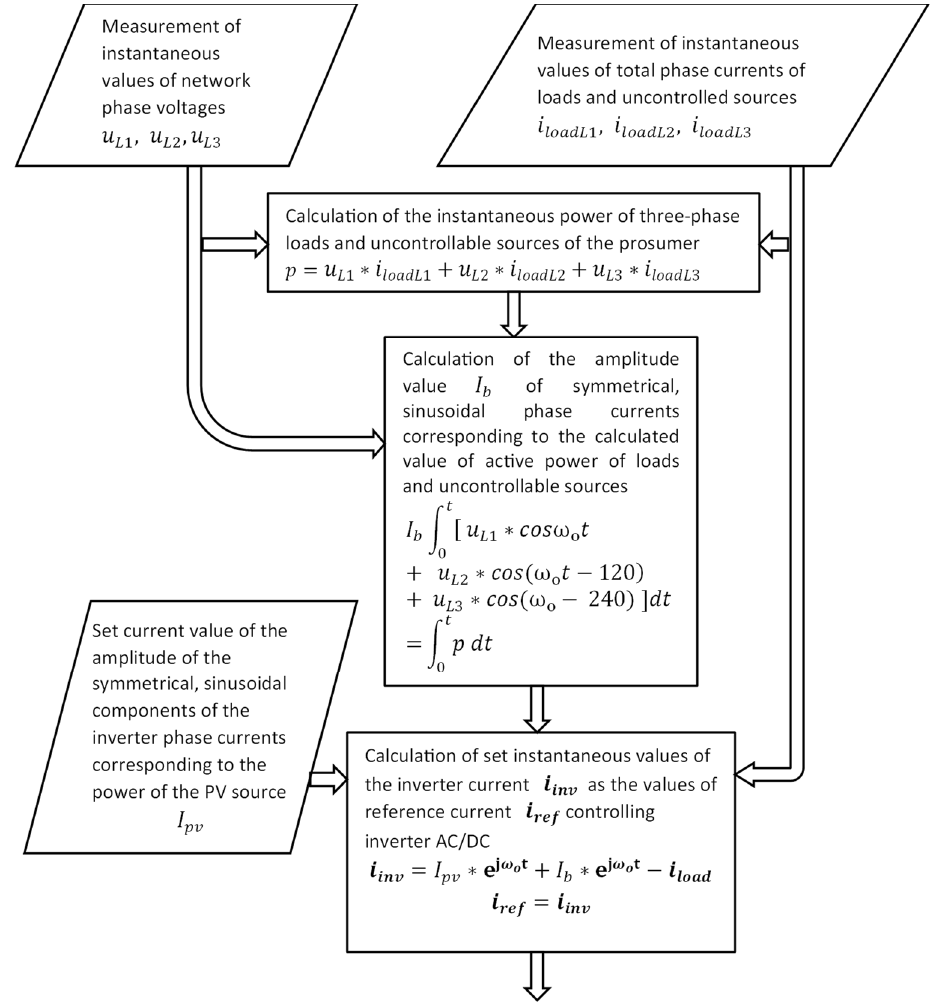
Figure 4. The flowchart of the inverter control algorithm. Load and PV pro fi les used in simulations are shown in Figure 5.